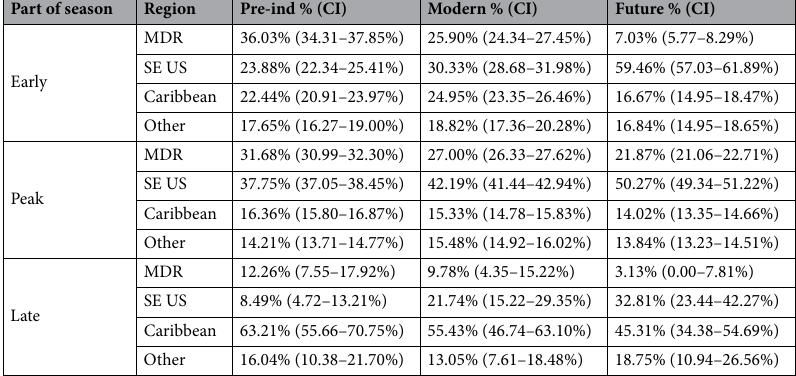
Table 1. Percentages of TC genesis throughout parts of the season, regions, and eras.